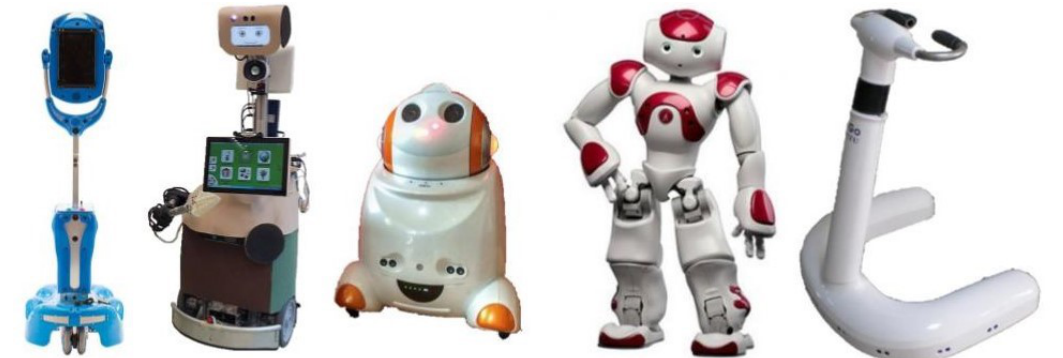
Figure 1. Sample robots extracted from the papers reviewed for this study. From left to right: Giraff [4], Hobbit [5], Matilda [6,7], Nao [8–11], iGo [12,13]. Various supports for older adults including